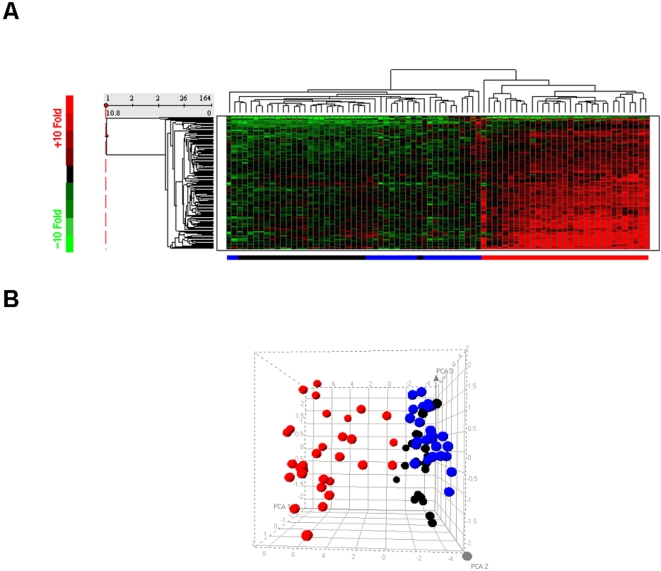
Clustering of up-regulated genes.A, Hierarchical clustering of all psoriasis samples profiled (blue: 21 normal, black: 23 paired nonlesional, and pink: 26 lesional skin from psoriatic patients; and red: 5 unpaired lesional skin from 3 psoriatic patients) using the 164 up-regulated type I IFN–inducible probe sets in lesional skin compared with those in mostly paired nonlesional skin. Each row corresponds to a single probe set; each column corresponds to a single sample. Branch lengths indicate the degree of similarity with joined samples, with a longer branch indicating a less similarity between joined samples. Red represents up-regulation vs control (ie, average expression of 21 normal samples), and green represents down-regulation vs control. B, 3-dimensional PCA plot of all psoriasis samples profiled using the 164 up-regulated type I IFN–inducible probe sets in lesional skin compared with those in mostly paired nonlesional skin. Each point represents 1 sample (blue: skin from healthy donors, black: nonlesional skin, red: lesional skin).